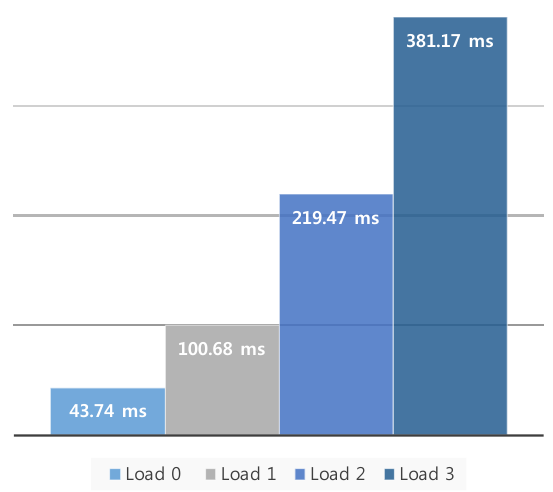
Figure 17. Change in the motion-to-photon latency according to the change in the graphics rendering load.